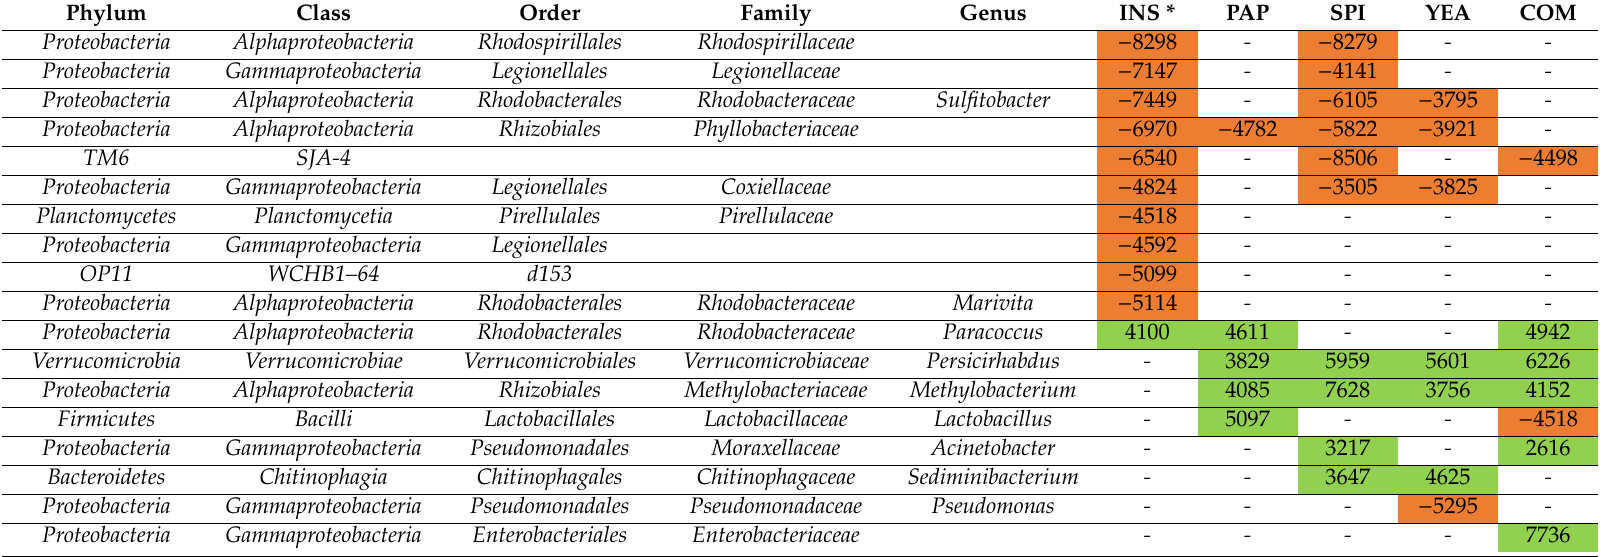
Table 3. Significantly di ff erent taxonomic groups at the genus level. Significant log scaled fold-changes of di ff erentially abundant genera ( p .adjust < 0.05) between experimental diets and the VEG control feed are presented (green: overabundant; orange: